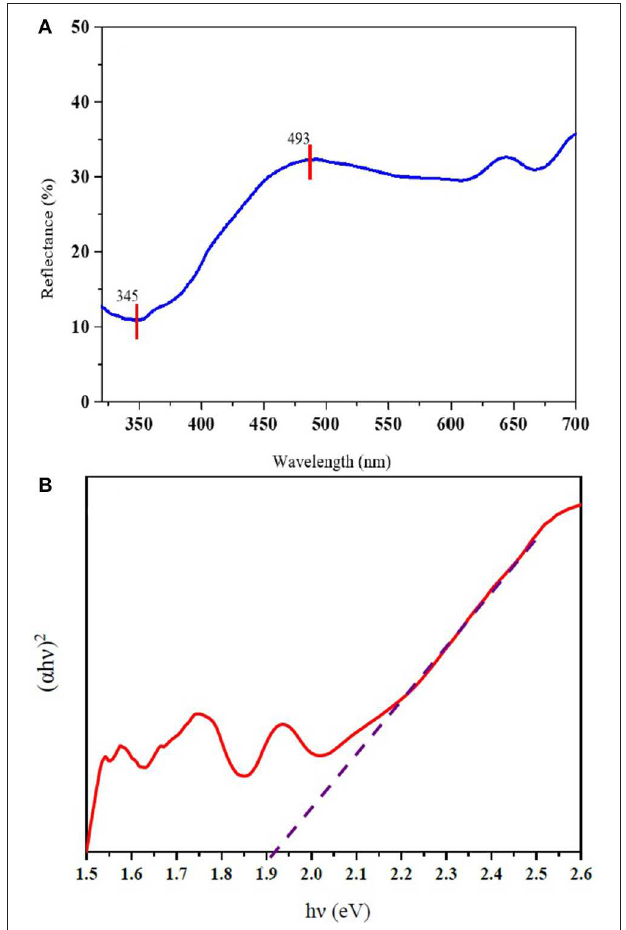
MoS 2 nanoflakes, with three different thicknesses (150, 230,